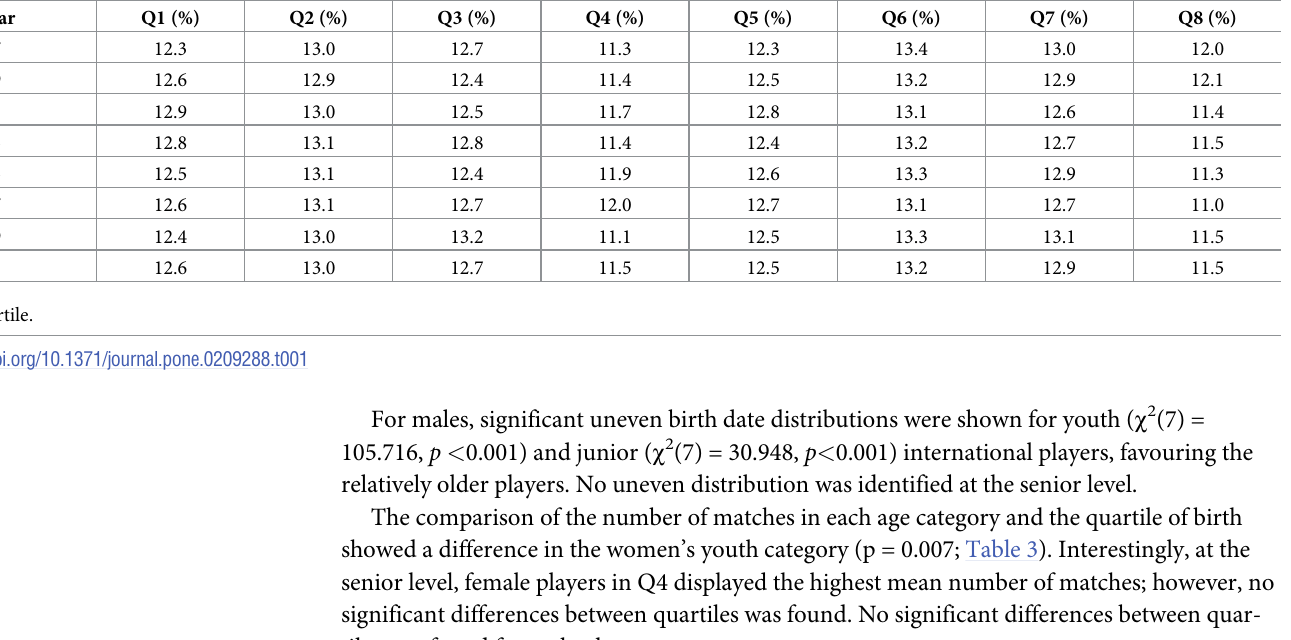
Table 1. Norwegian birth-distribution according to quartiles, matching the participants in the sample. Birth year